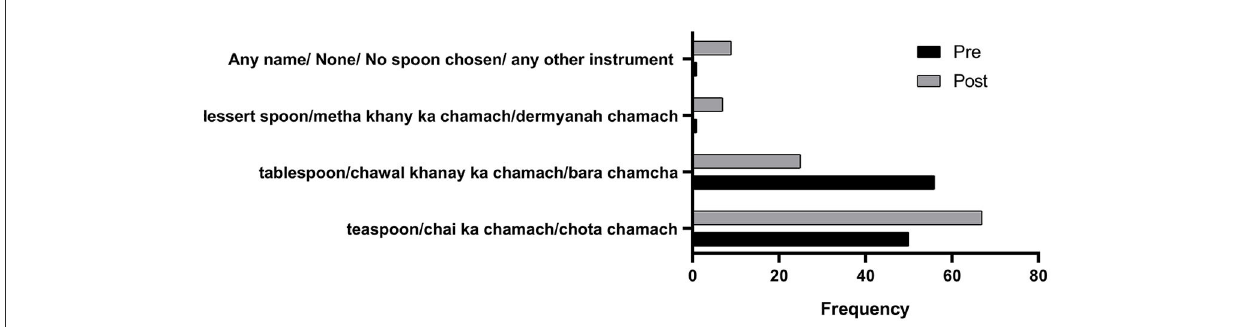
FIGURE4 Pre- and post-intervention responses on the name of the spoon chosen for medicine administration. **** means very highly significant.